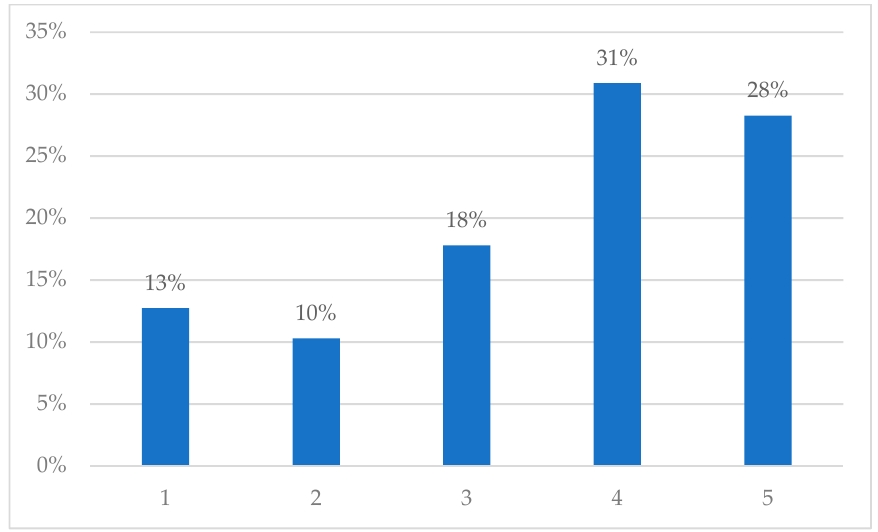
Figure 2. Summary of the responses to Question 2.